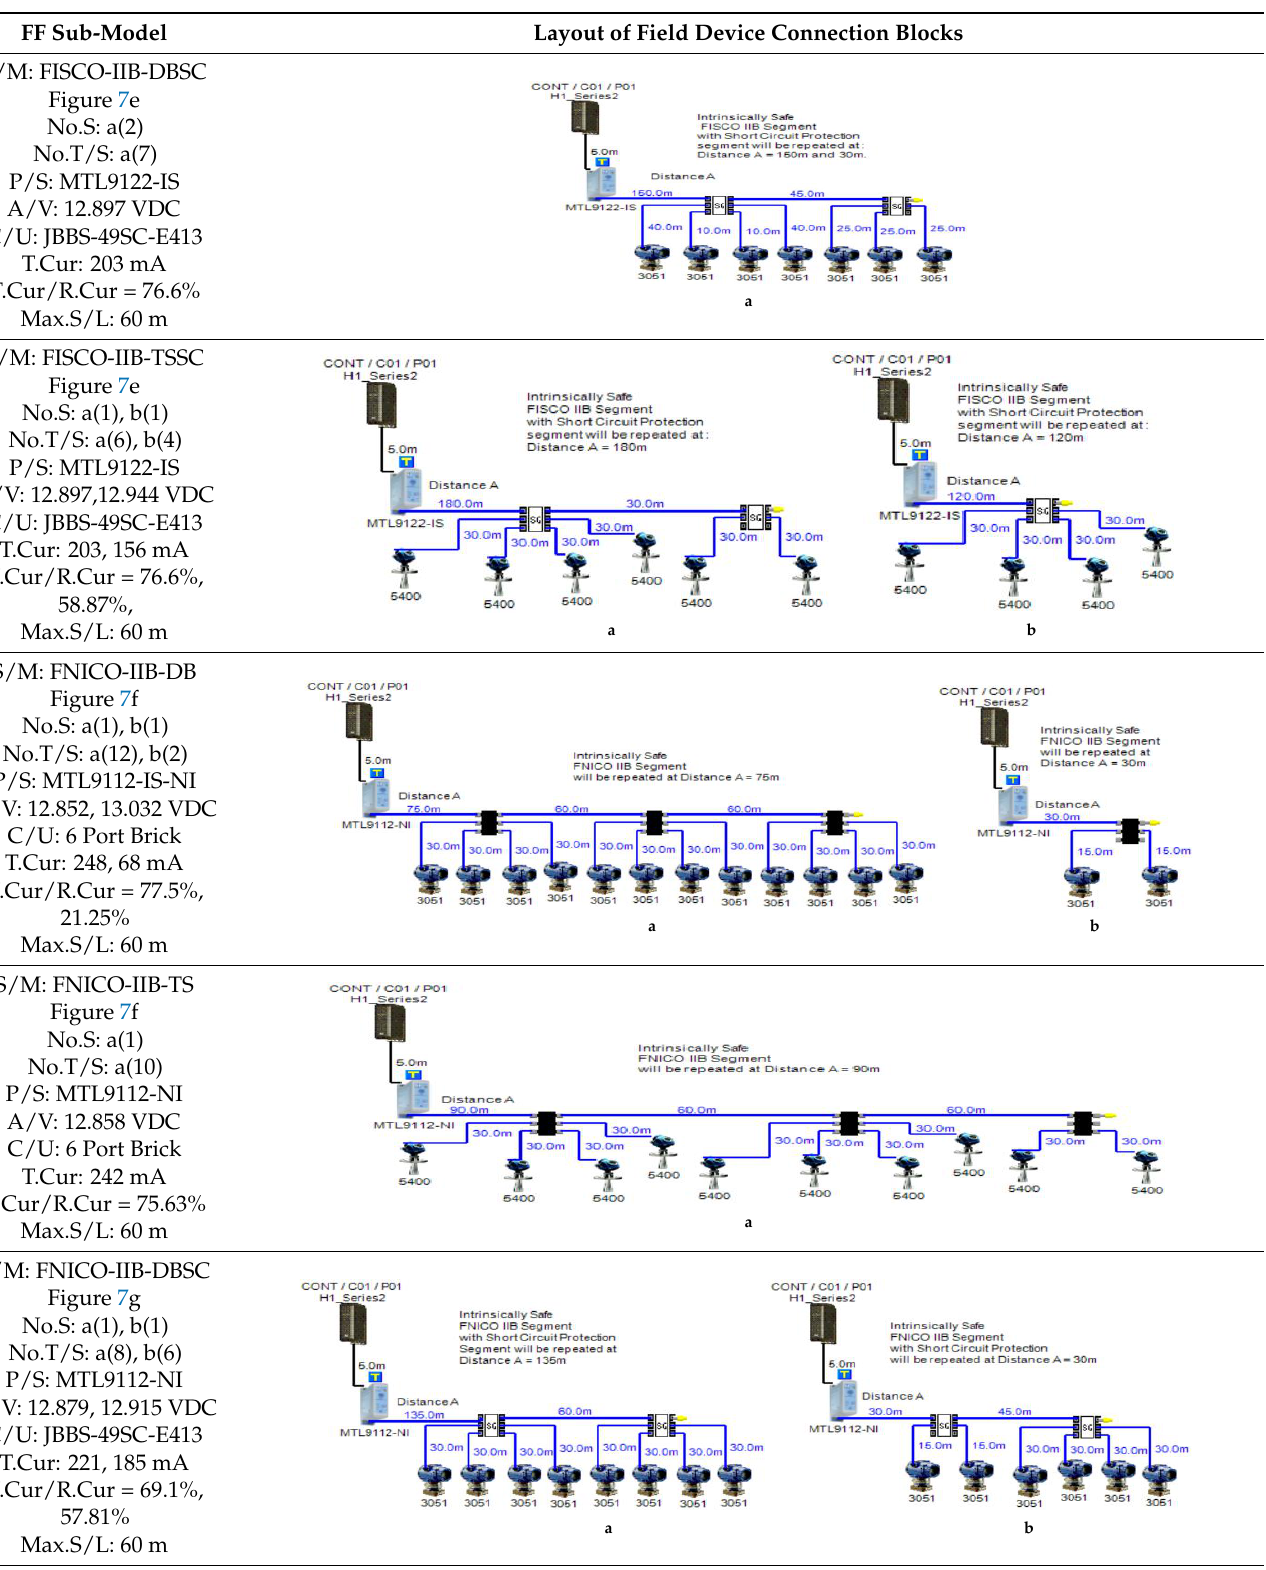
Figure 7g No.S: a(1), b(1)